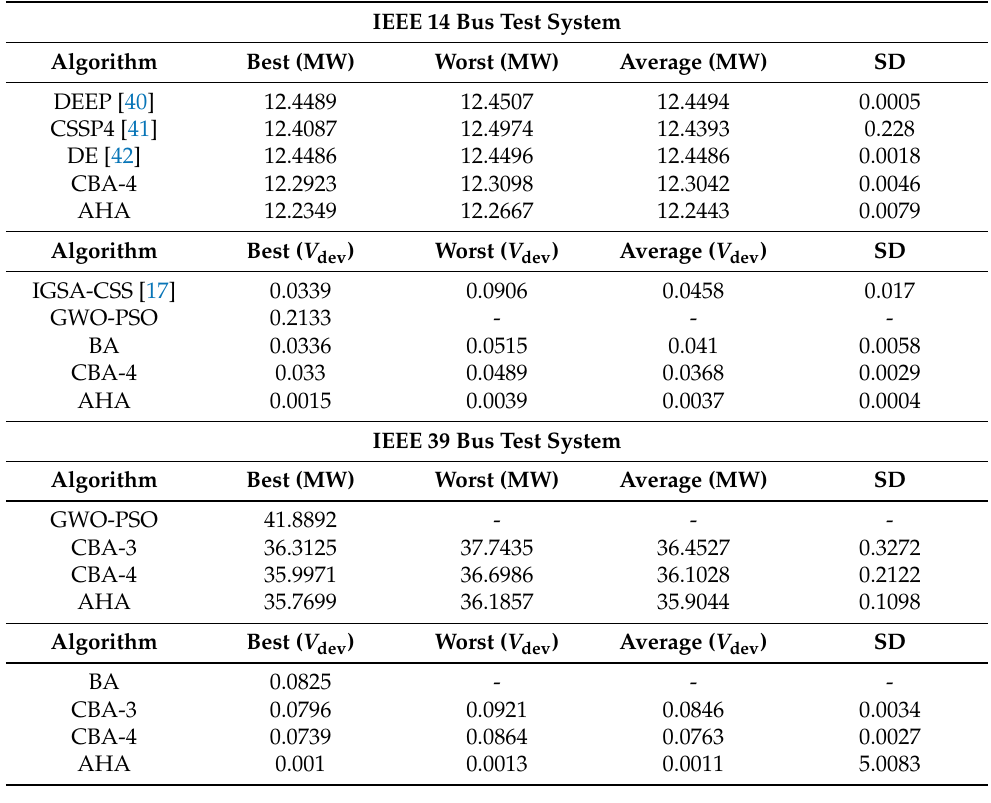
Table 11. Statistical tests on the IEEE 14 and 39 bus test systems for cases 1 and 2 optimized by the proposed AHA-based